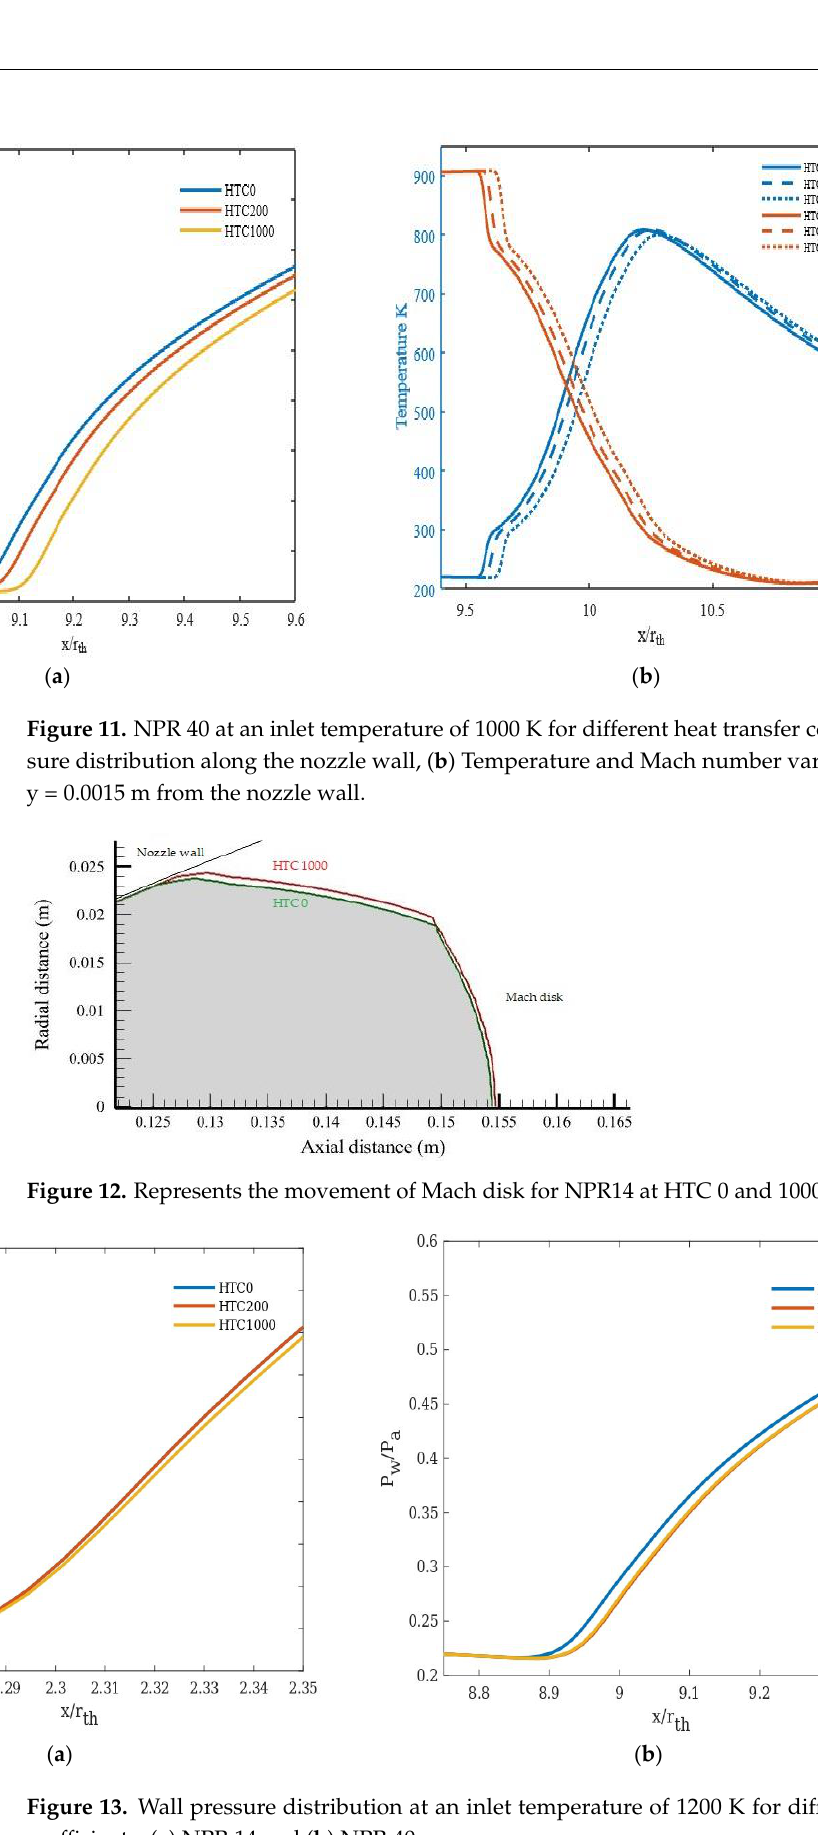
Figure 10. NPR 30 at an inlet temperature of 1000 K for different heat transfer coefficients: ( a ) Pres-